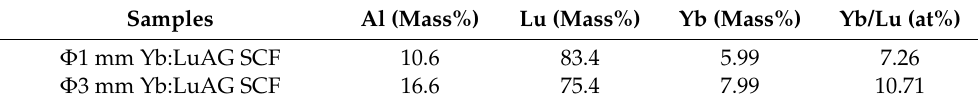
Table 1. The Yb 3+ dopant concentration of the Yb:LuAG